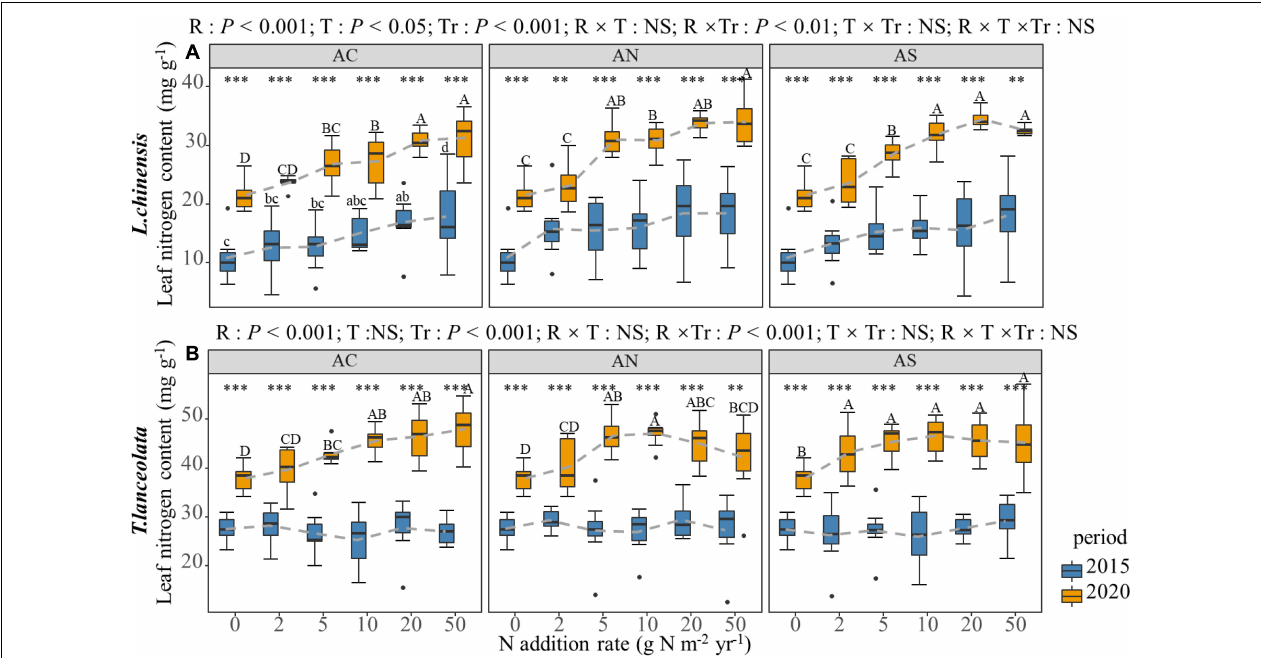
FIGURE 1 | Effects of short- and long-term nitrogen deposition on LN of two species: (A) Leymus chinensis ; (B) Thermopsis lanceolata . The three-way ANOVA was used to test the effects of Pr, T, and R on LN. The effects of the nitrogen compound type alone and with N addition rate and year on LN are not significant (NS, P > 0.05), thus one-way ANOVA (Tukey’s HSD) and t -tests are used to test the effects of N addition rate and year on LN. Different lower-case and upper-case letters indicate significant differences ( P < 0.05) in LN among nitrogen addition rate in the 2015 and 2020 plots, respectively. The asterisk above the picture indicates the significant difference between the two years under each nitrogen addition rate. Note: ∗∗ P < 0.01; ∗∗∗ P < 0.001. CK: non-fertilizer control = 0, N1 = 2, N2 = 5, N3 = 10, N4 = 20, and N5 = 50 kg N ha − 1 yr − 1 ; AC (NH 4 HCO 3 ), AN (NH 4 NO 3 ), AS [(NH 4 ) 2 SO 4 ]. The gray dashed line is the connection of the mean